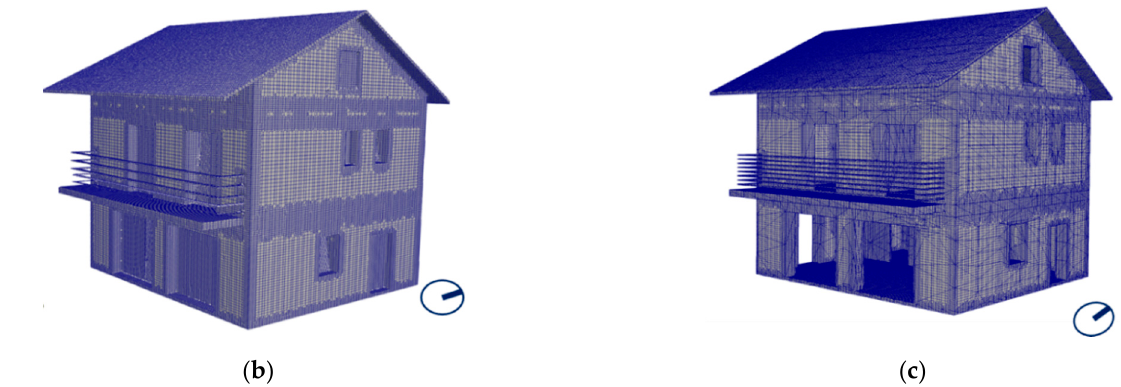
Figure 5. Computational domain. ( a ) Wind tunnel domain; ( b ) meshed geometry CFD 1; and ( c ) meshed geometry CFD 2.